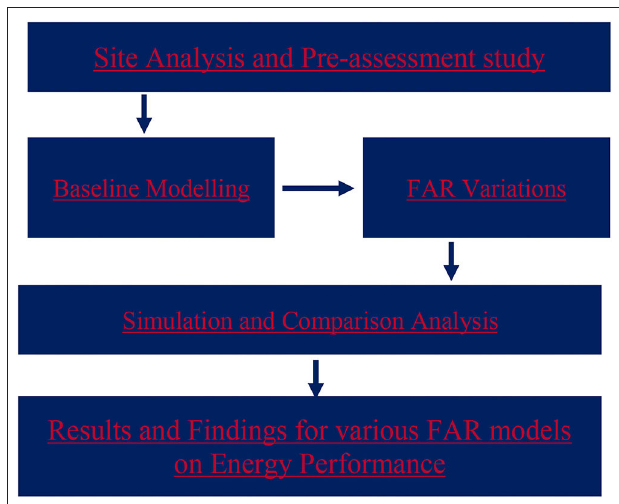
FIGURE 1 | Methodological framework of the study in four steps (source: authors’